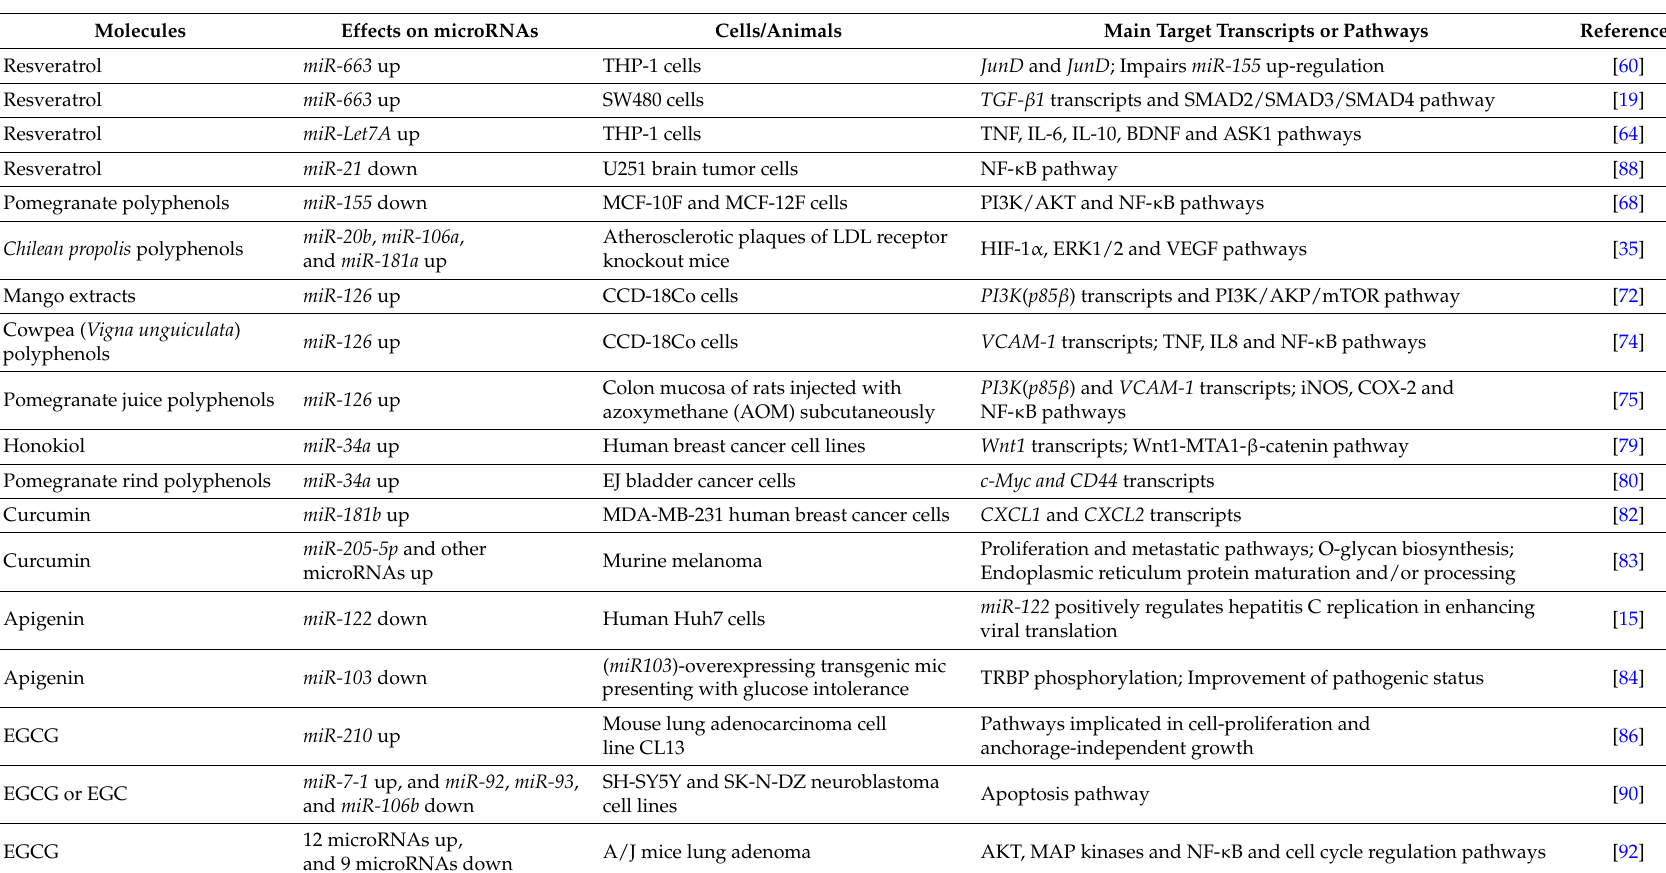
Table 1. MicroRNAs implicated in inflammatory response whose expression was modified by different phenolic natural products, and their main target transcripts and